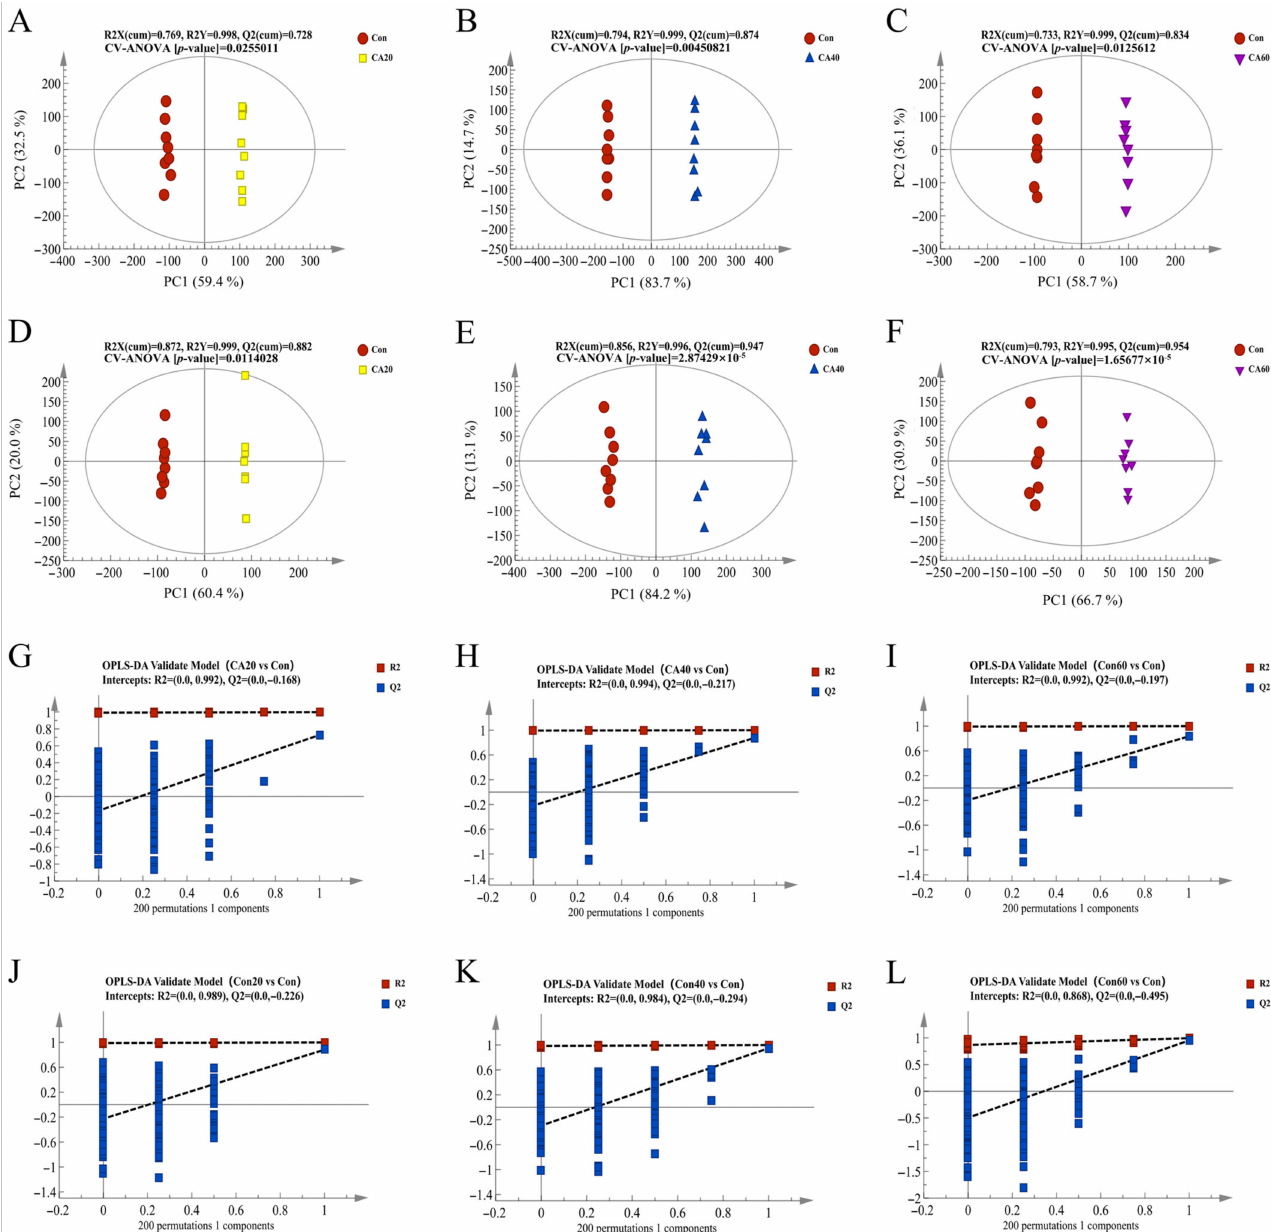
Figure 4. The OPLS-DA analysis of crucian carp kidney under different concentrations of carbonate alkali exposure. ( A – C ) The OPLS-DA plot of positive ion mode. ( D – F ) The OPLS-DA plot of negative ion mode. ( G – I ) The OPLS-DA permutation test of positive ion mode. ( J – L ) The OPLS-DA permutation test of negative ion mode. Con represents the freshwater control group, CA20 represents the 20 mmol/L NaHCO 3 exposure group, CA40 represents the 40 mmol/L NaHCO 3 exposure group, and CA60 represents the 60 mmol/L NaHCO 3 exposure